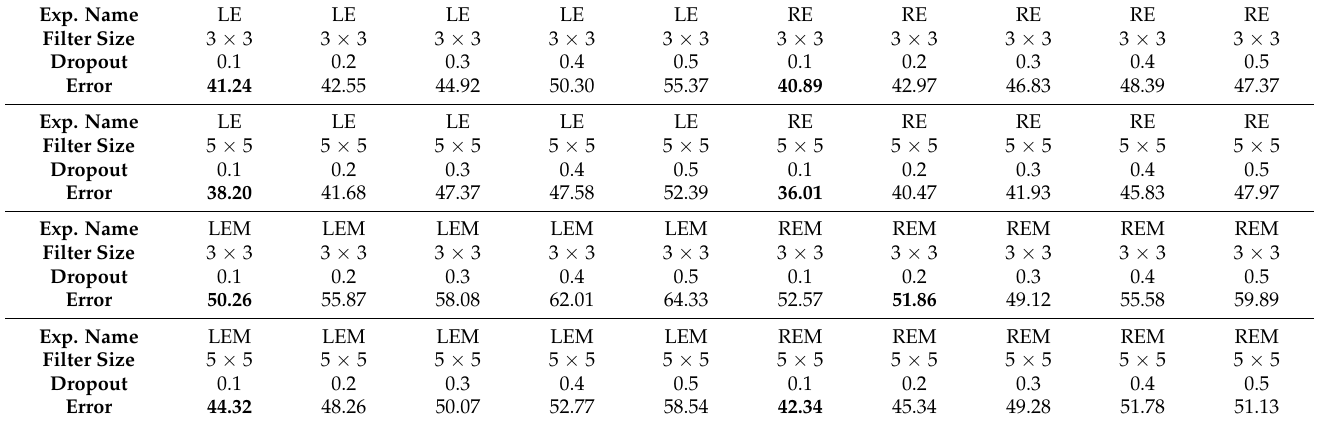
Table 2. Results of LE and and RE with and without a mask (learning rate =